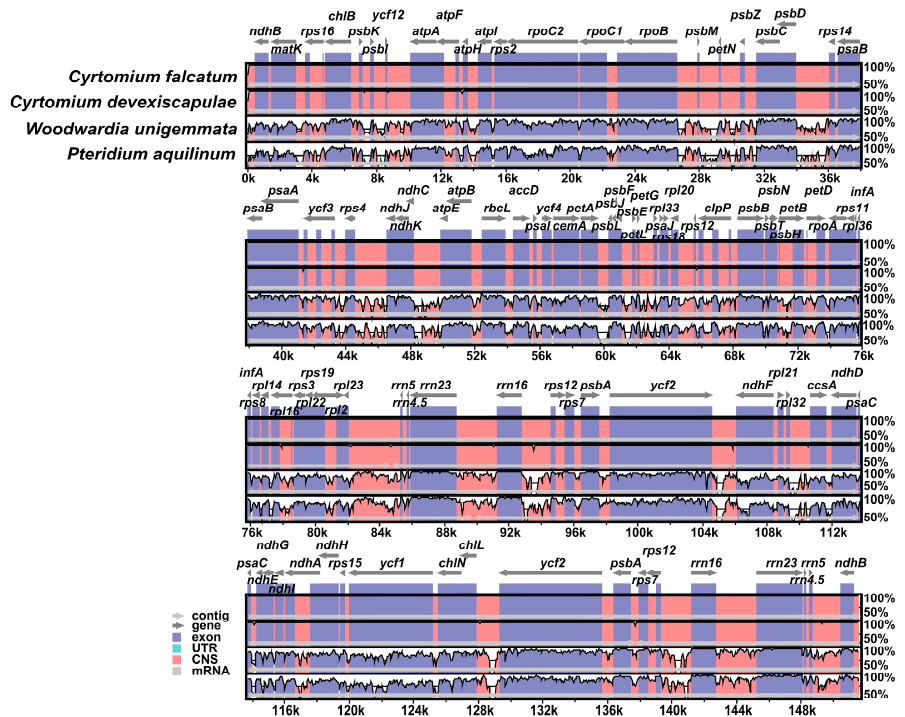
Figure 2. Comparison of the cp genome sequences of C. falcatum , Cyrtomium devexiscapulae , Woodwardia unigemmata and Pteridium aquilinum generated using mVISTA software. The gray arrows indicate the position and direction of each gene. The red and blue areas indicate intergenic and genic regions, respectively. Black lines define regions of sequence identity with C. falcatum , using a 50% identity cutoff. UTR: untranslated region; CNS: non-coding sequences. Genes 2016 , 7 , x FOR PEER REVIEW